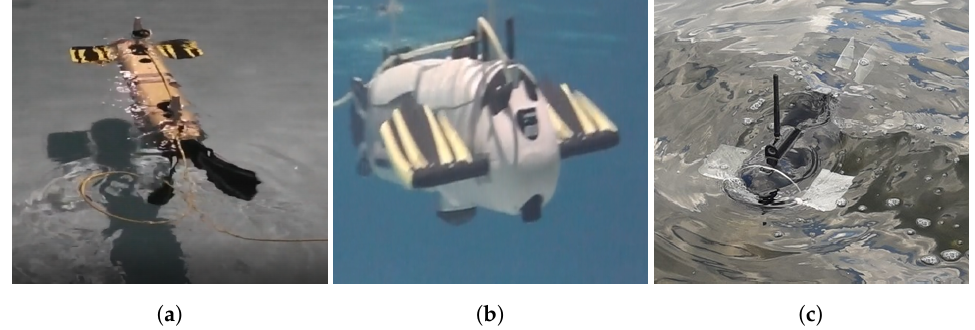
Figure 1. BUUV with propulsion system made of two flexible tail and side fins ( a ) top back view; ( b ) front view; and ( c ) small